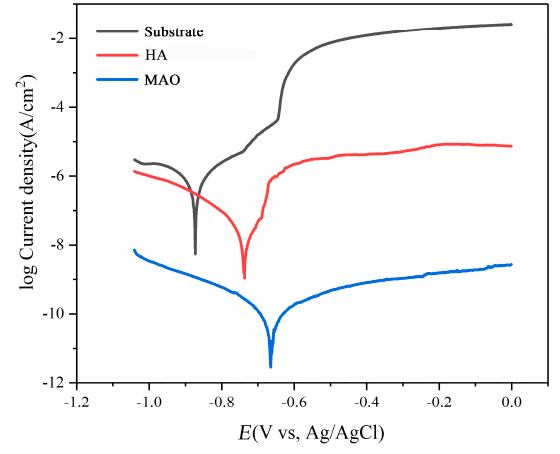
Figure 5. Potentiodynamic polarization curves of the substrate, and the HA- and MAO-treated 7050